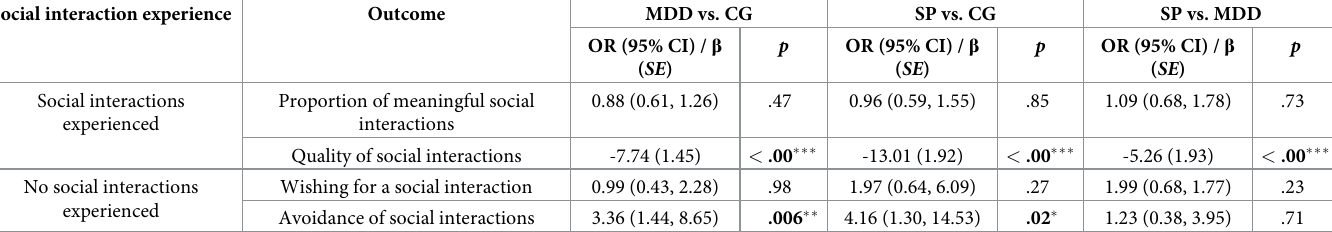
Table 2. Differences in the proportion and quality of experienced social interactions, and differences in the level of wishing for a social interaction and avoidance of social interactions. Social interaction